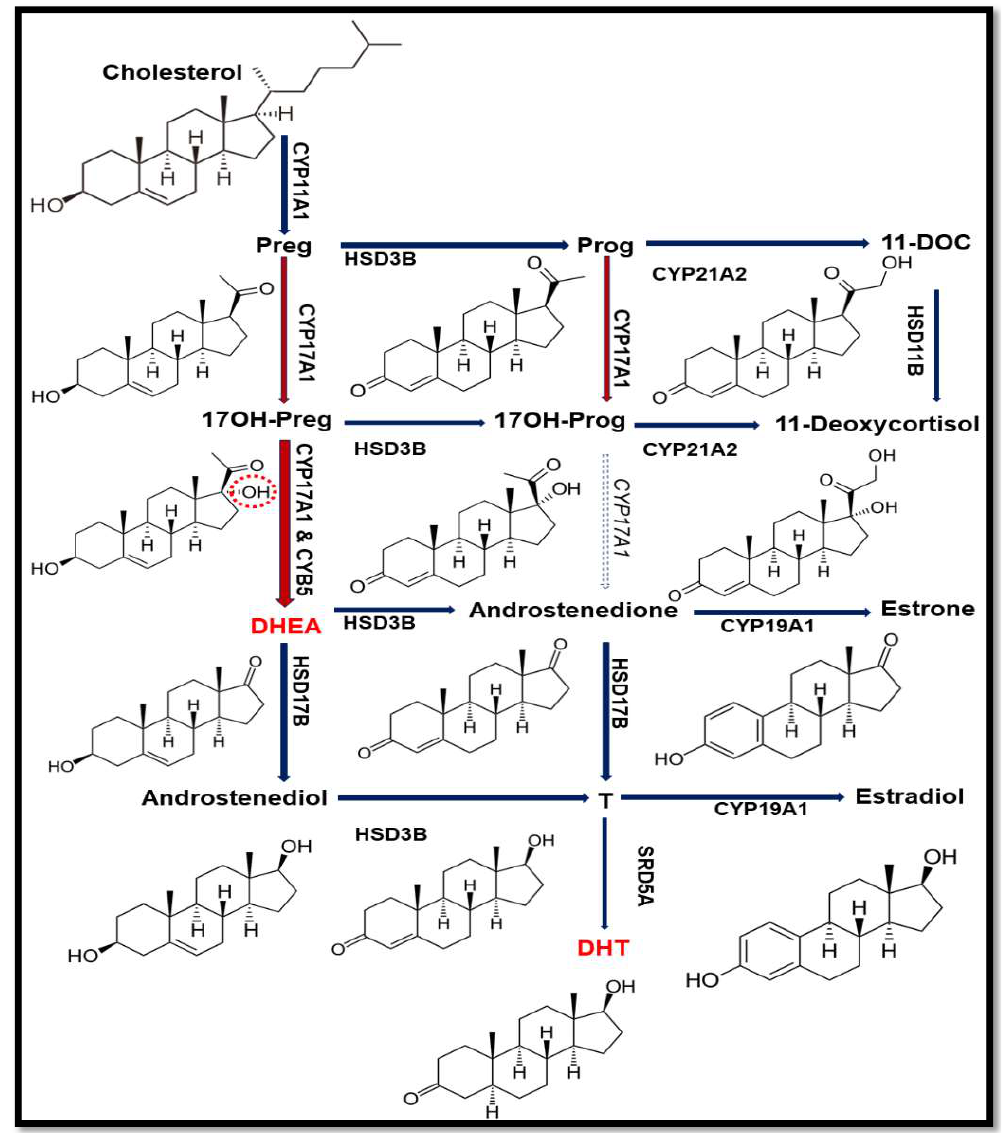
Figure 2. Steroid biosynthetic pathway. In humans, 17,20 lyase activity of CYP17A1 converts 17α-hydroxypregnenolone (17OH-PREG) to dehydroepiandrosterone (DHEA) but does not effectively convert 17α-hydroxyprogesterone (17OH-PROG) to androstenedione. The DHEA is the precursor for androgen production and (dihydrotestosterone) DHT is the potent form of androgen with higher affinity towards androgen receptor (AR) than testosterone (T). The 17α-hydroxy position of 17OH-PREG is highlighted in red to show the difference from PREG. Along with CYB5A, higher molecular ratios of POR and phosphorylation of CYP17A1 also influence 17,20 lyase activity [17–21]. Recently several X-ray crystal structures of solubilized human CYP17A1 have been reported, but the structural basis of 17α-hydroxylase and 17,20, lyase activities remains unknown [22–26]. Generally, the mutations that affect the steroid-binding domain of CYP17A1 or disturb the interaction with P450 oxidoreductase (POR) for electron transfer, cause combined 17α-hydroxylase and 17,20 lyase deficiency, and are those more frequently found in humans [4,25]. Very few point mutations in CYP17A1 (R347C/H, R358Q) have been reported to cause